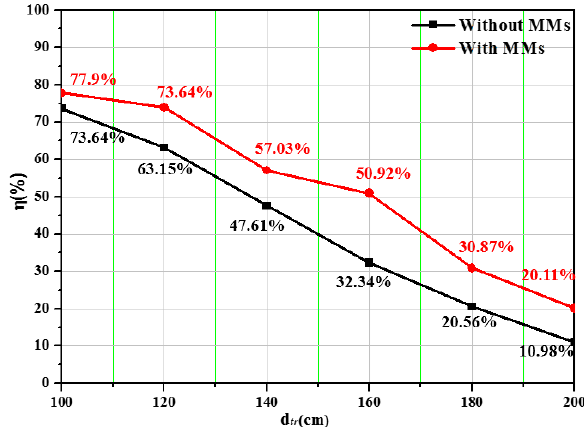
Figure 14. Comparison of transfer efficiency before and after the MMs loading.